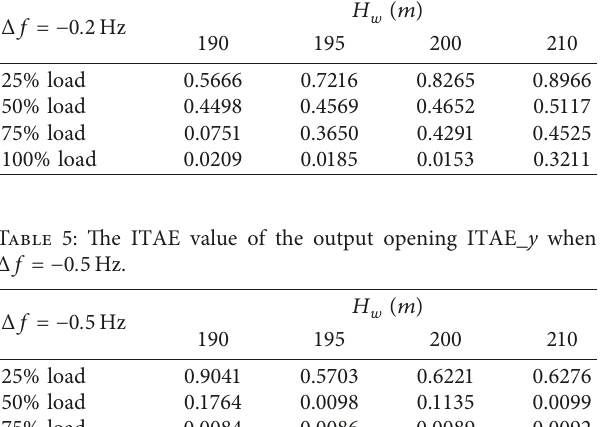
Table 4: The ITAE value of the output frequency ITAE _f when Δ f � − 0 . 2Hz. Δ f � − 0 . 2Hz